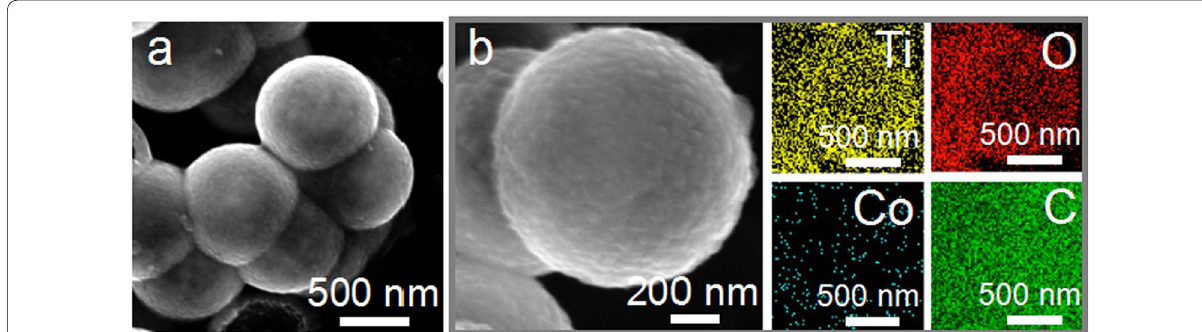
Fig. 3 a SEM image; b high-resolution SEM image and corresponding EDS mappings of Co@TiO 2